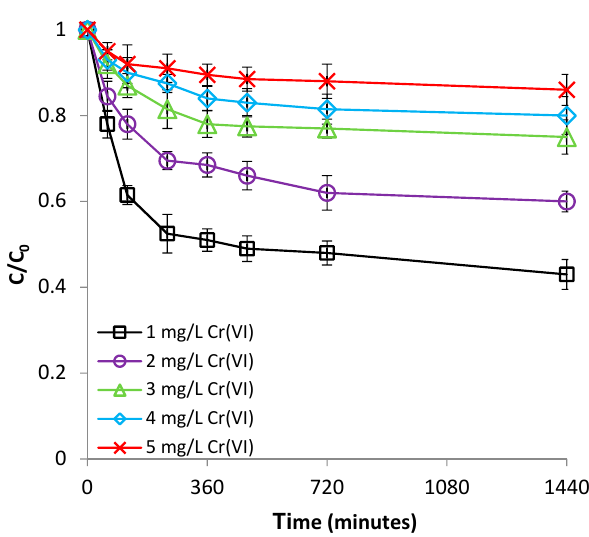
Figure 10. Effect of Cr(VI) concentration on Cr(VI) removal by bentonite.